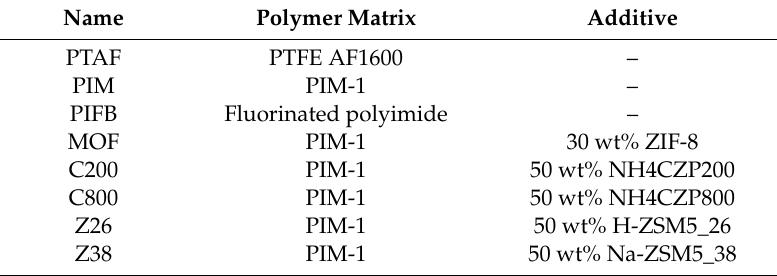
Figure 2. Images of an interdigitated electrode: ( A ) SEM image of empty electrode; ( B ) optical image of a (BioSpot) coated chip, before drying; ( C ) SEM image of a coated electrode (part is burned off by SEM electron beam). Table 1. Coating formulations that were applied to the interdigitated electrodes. PTAF = soluble polytetrafluoroethylene, PIM = polymer of intrinsic microporosity, PIFB = polyimide having fluorinated building blocks, MOF = metal organic framework.